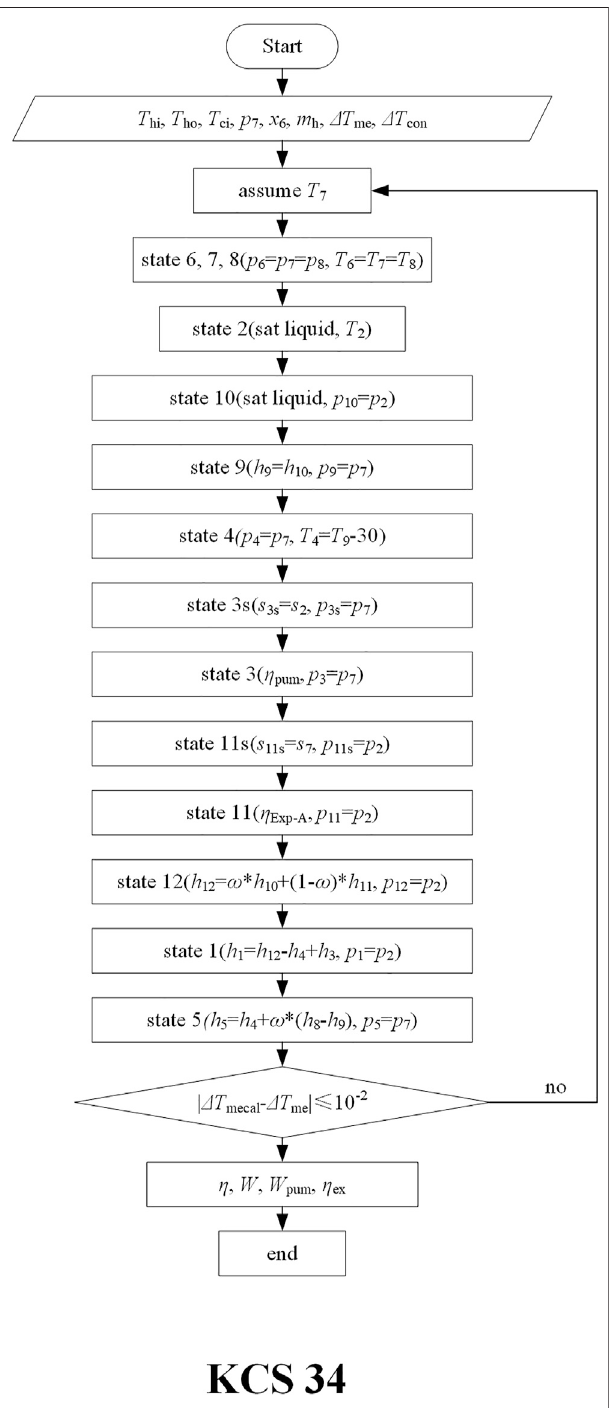
FIGURE 5 | The fl owchart of the calculation program for the original KCS 34.